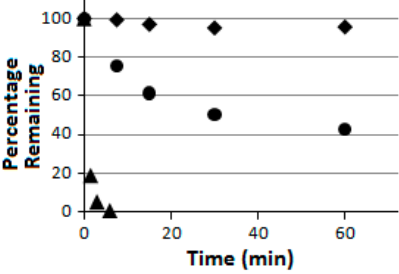
Figure 4. The pronase digestion profiles of compounds 5 ( ◆ ), 6 ( ● ), and the linear pentapeptide H 2 N-HK-(N ε -acetyl-lysine)-LM-COOH ( (cid:78)